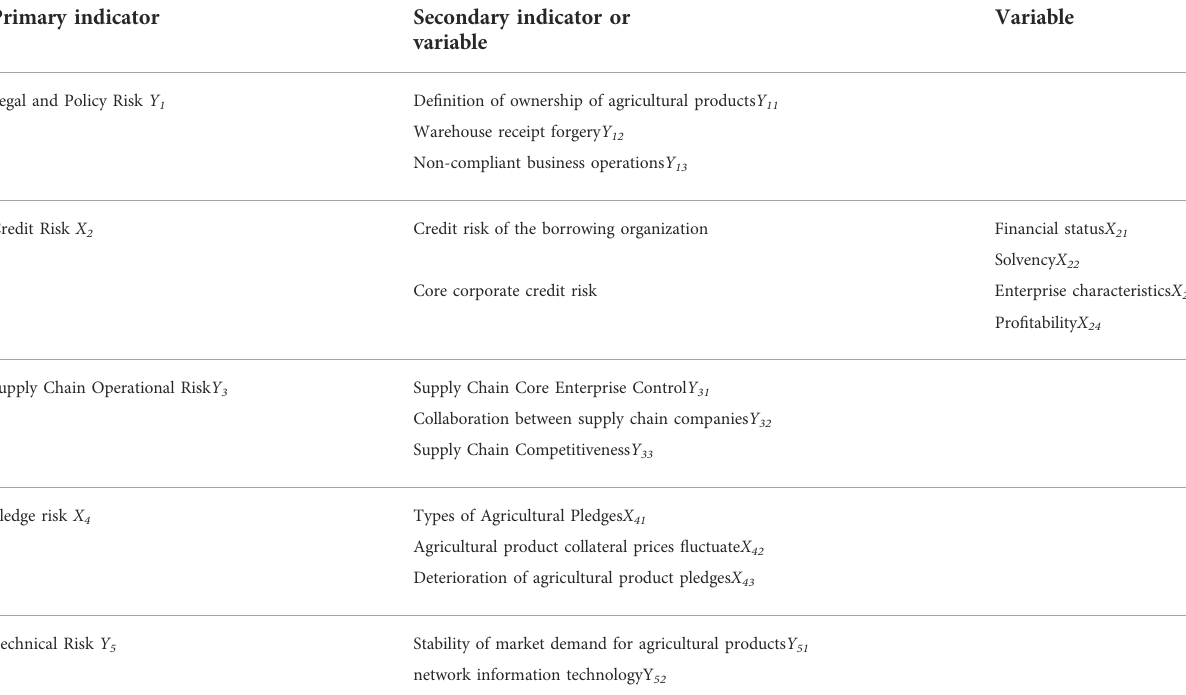
TABLE 1 Financial Risk Evaluation Index System of Agricultural Product Supply Chain (Source: sorted by the authors according to the type of risk). Primary